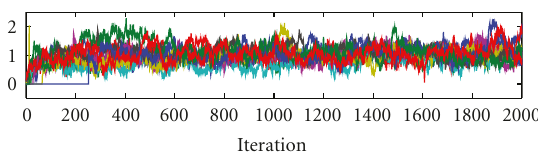
Figure 2: 10 Independent sampling chains of x 1,1 .